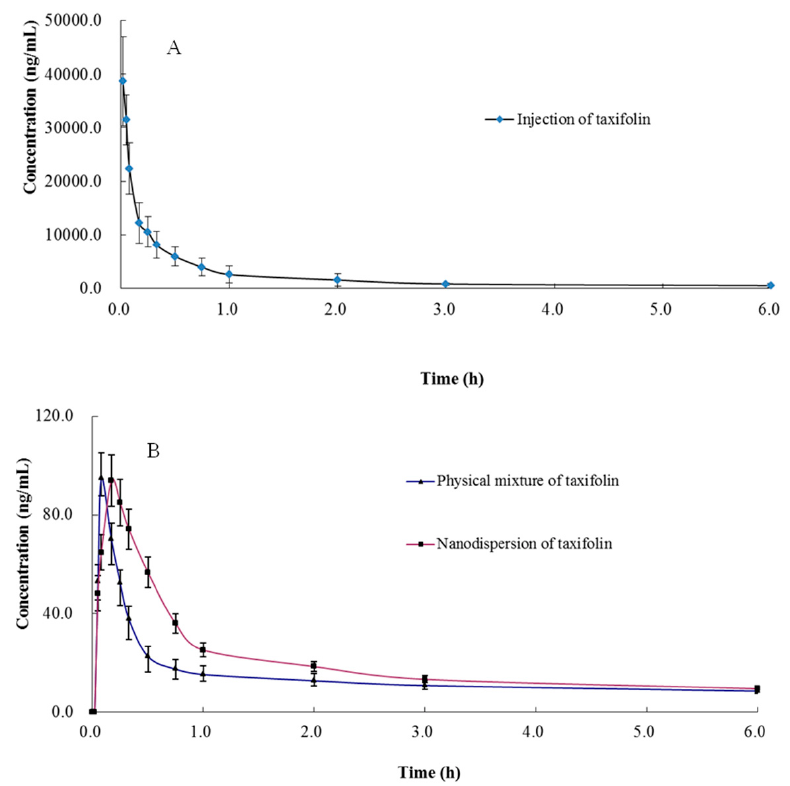
Figure 2. Mean ± SD ( n = 6) plasma concentration–time curves of taxifolin ( A ) intravenous administration of taxifolin at 15 mg/kg ( B ) oral administration of physical mixture of taxifolin and nanodispersion of taxifolin 15 mg/kg.